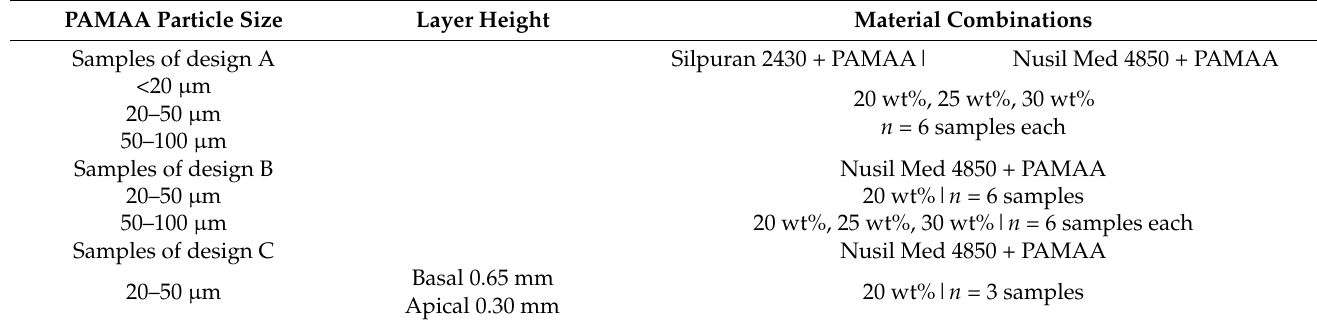
Table 2. List of manufactured samples with designs according to Figure 2. The investigated silicone rubbers are given for each design, as well as the PAMAA particle size and the respective weight percentage used in the compounds.